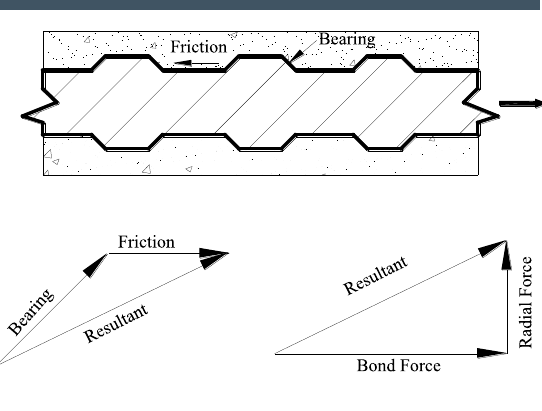
Figure 1. Transfer of forces at the interface.